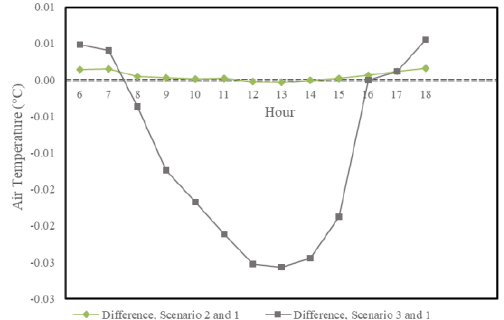
Figure 9. Difference in the hourly air temperature between scenarios 3 and 1, and between scenarios 2 and 1. Very minimal difference were observed in all the scenarios, with Scenario 3 leading to a decrease in air temperature from 8:00 to